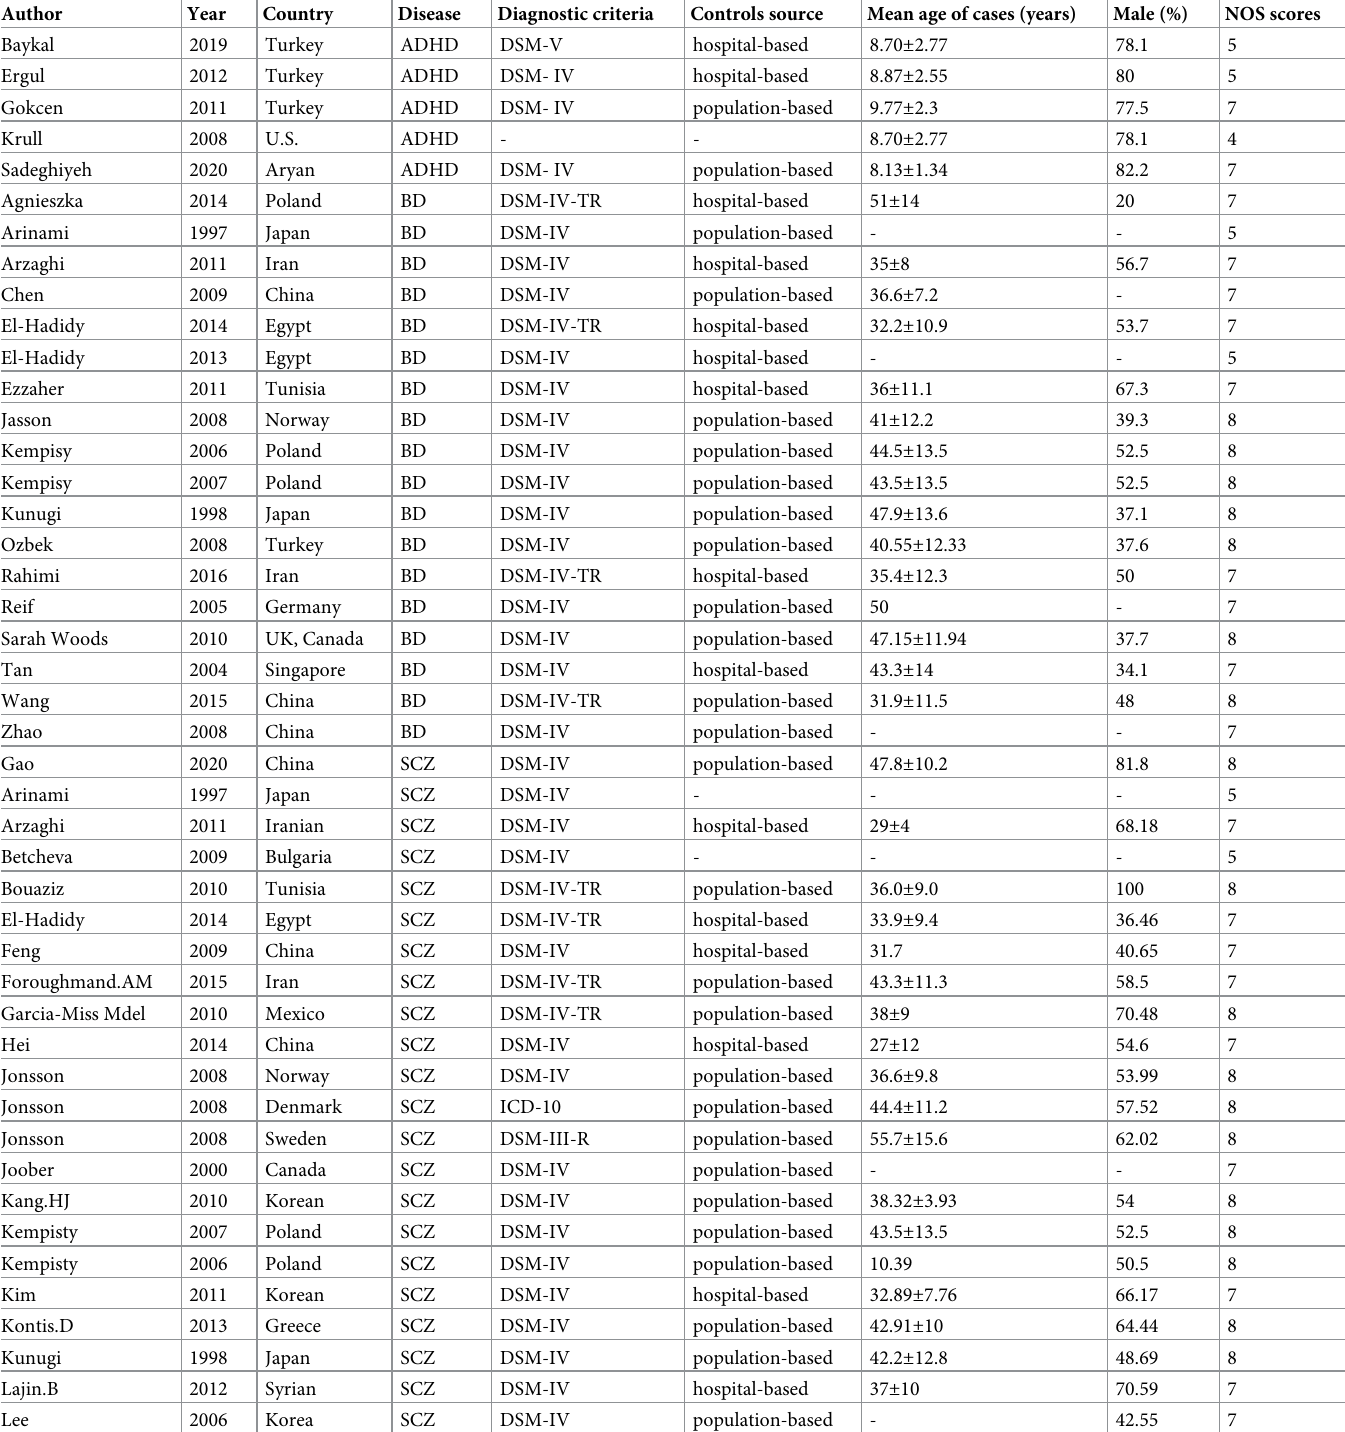
Table 1. Baseline characteristics of qualified studies in this